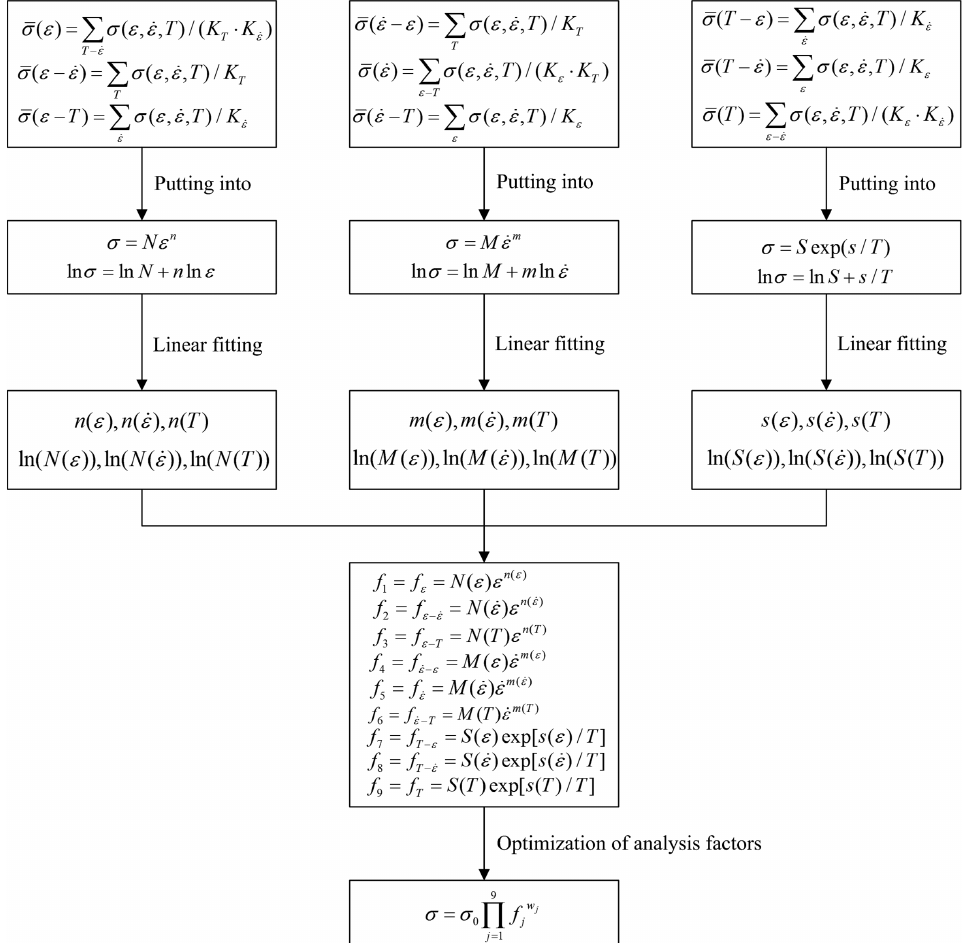
Figure 5: Diagram of determination for constitution equation based on modified double multiple nonlinear